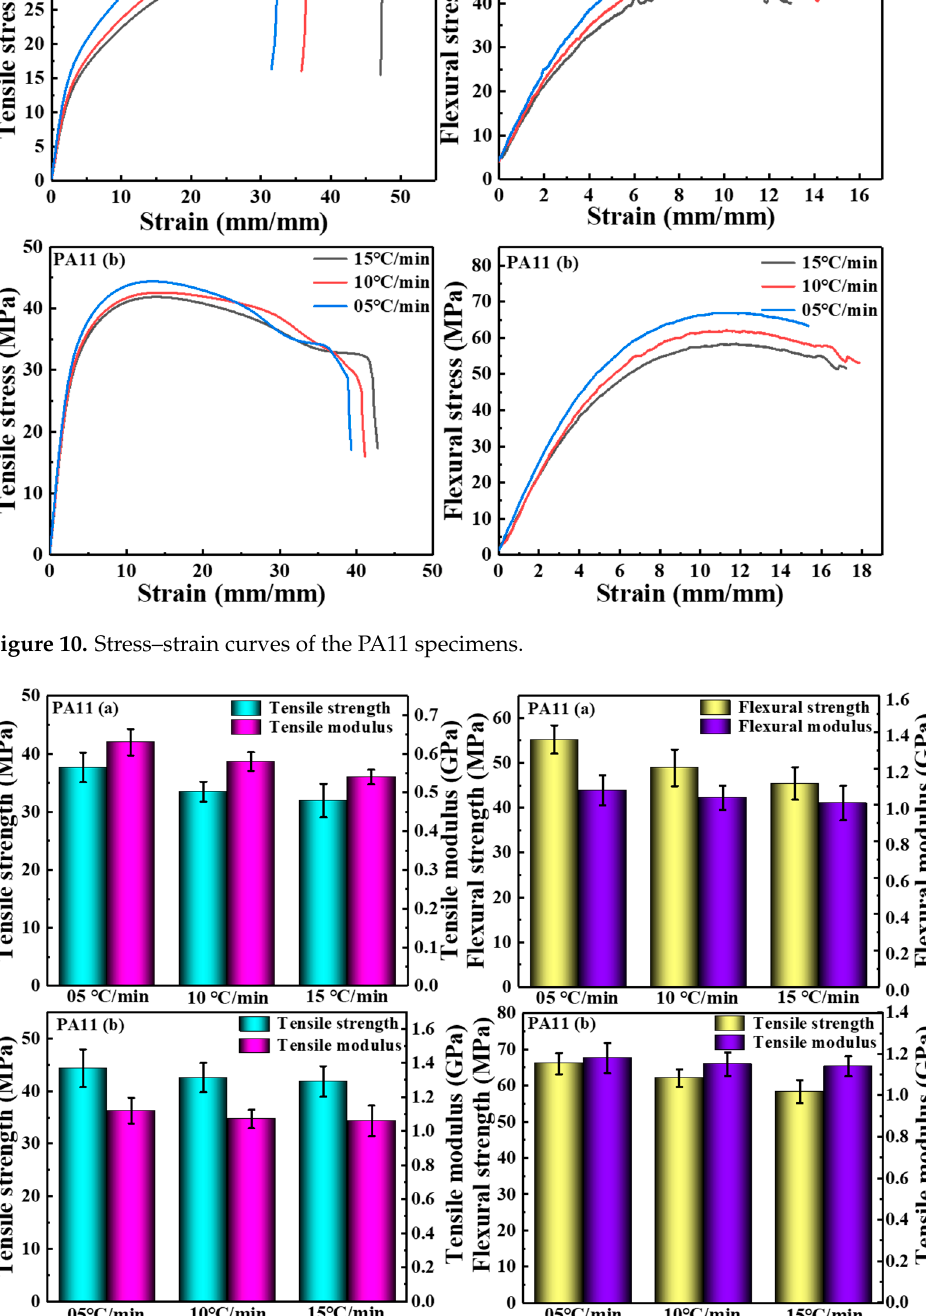
Figure 11. Mechanical properties test results.